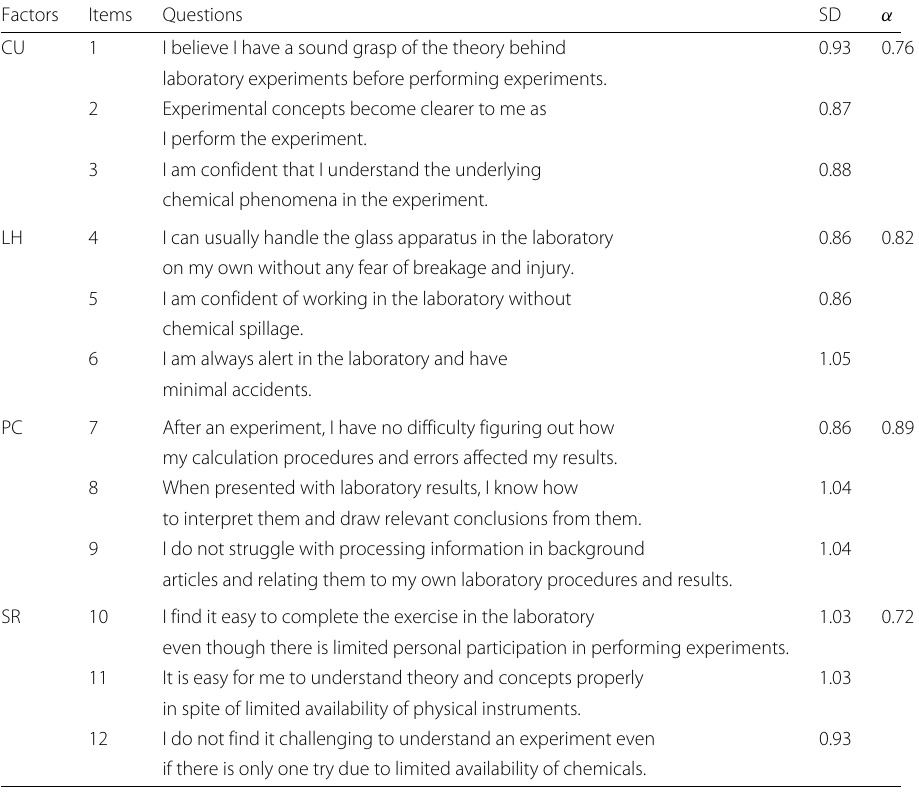
Table 2 Experimental self-efficacy questionnaire